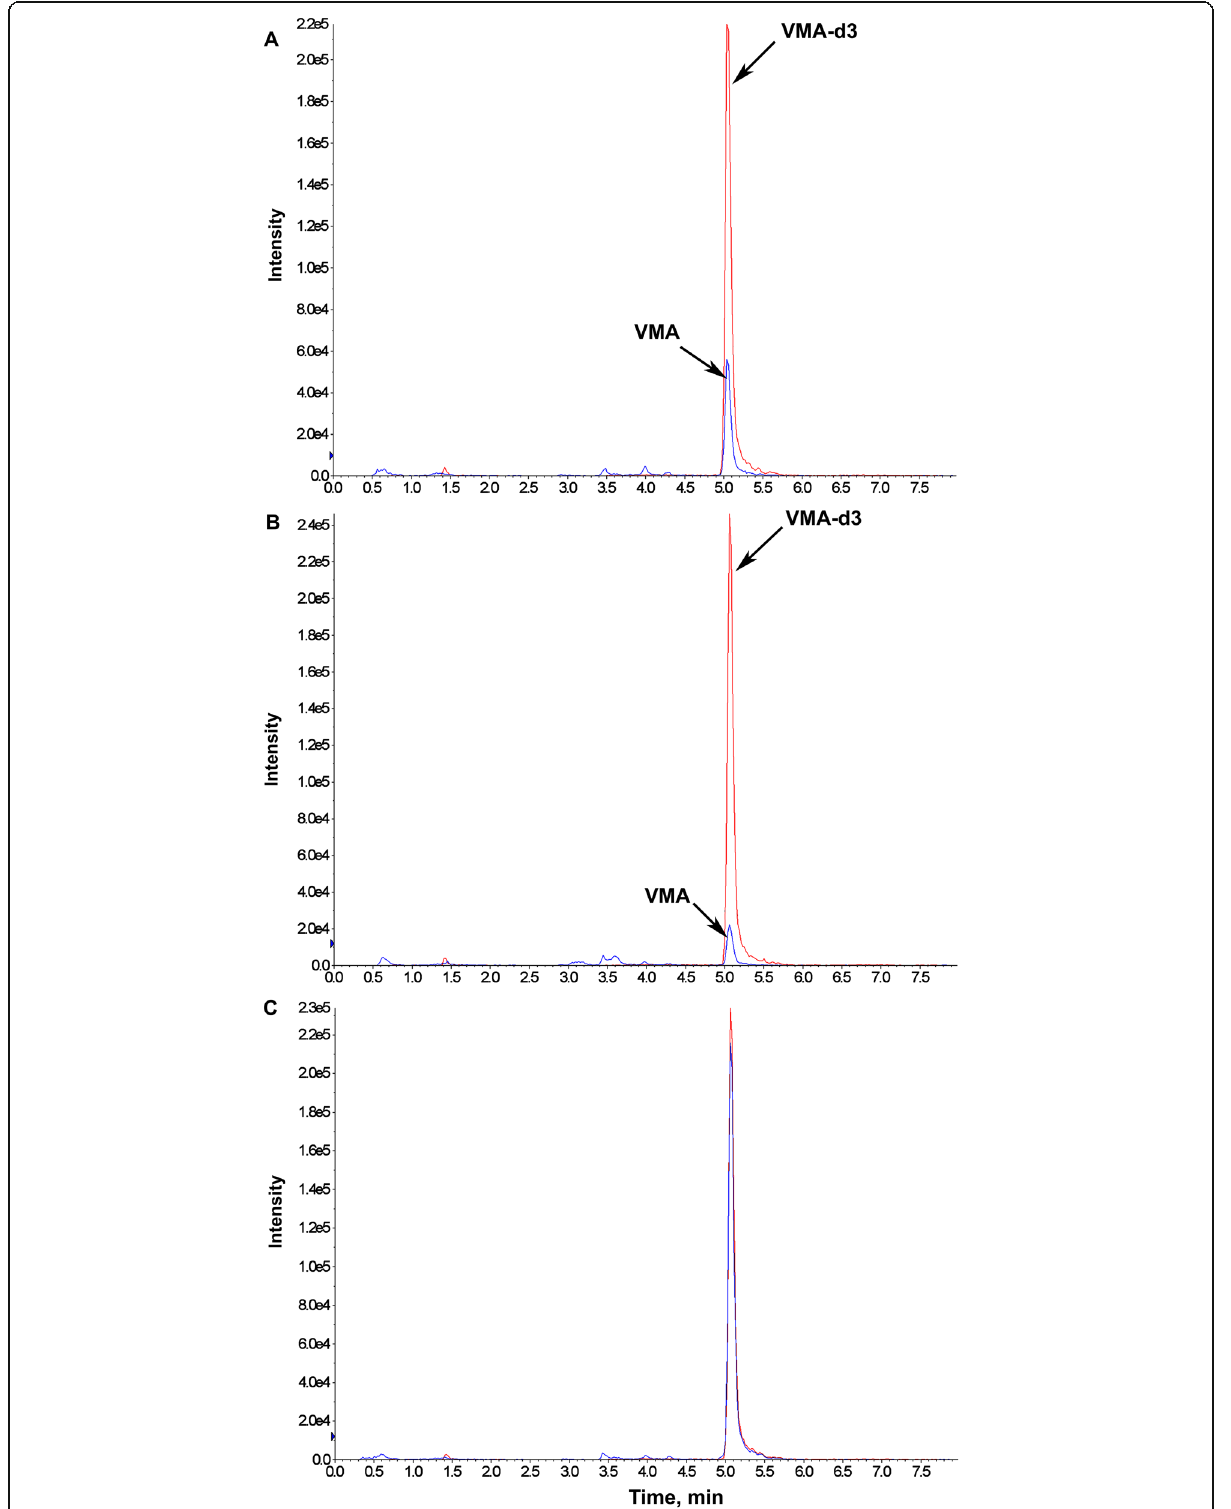
Fig. 1 LC-MS/MS chromatograms of a 1 μ g/mL calibration standard, b healthy patient urine, and c abnormal patient urine: vanillylmandelic acid (VMA), vanillylmandelic acid-d3